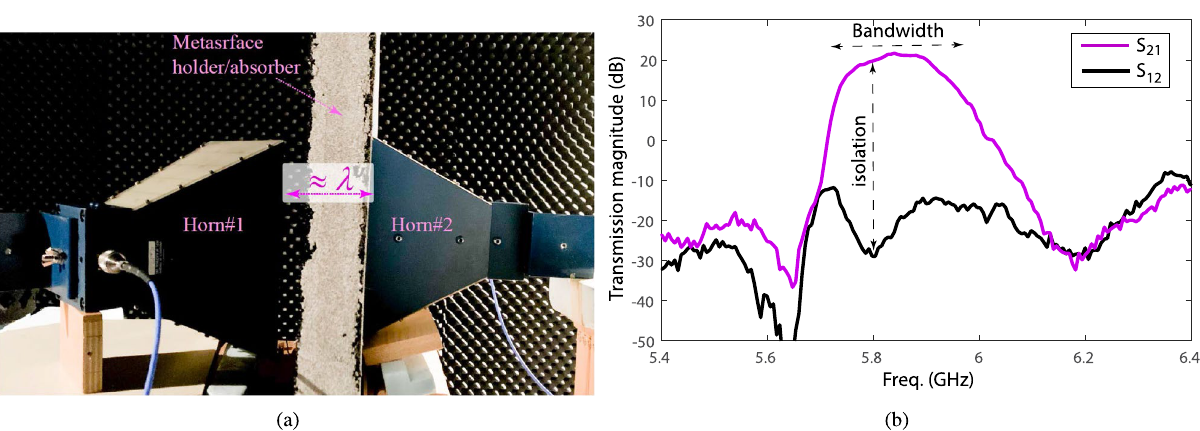
Figure 8. Near-field experiment. ( a ) An image of the near-field experimental set-up. ( b ) Near-field frequency response, showing a fractional frequency bandwidth of 4.3% , i.e., from 5.73 to 5.98